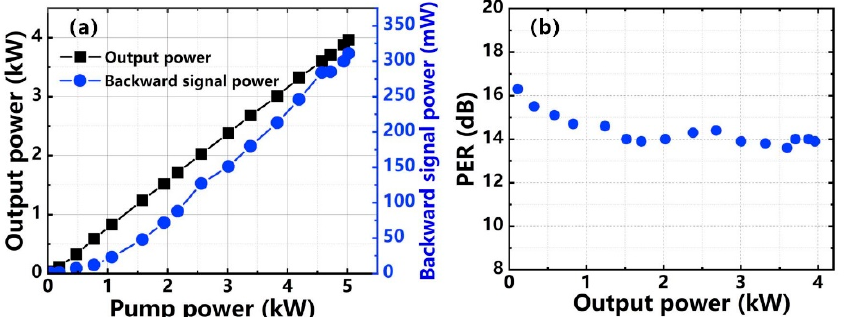
Figure 4. Output characteristics of the main amplifier: ( a ) Power curve; ( b ) PER.